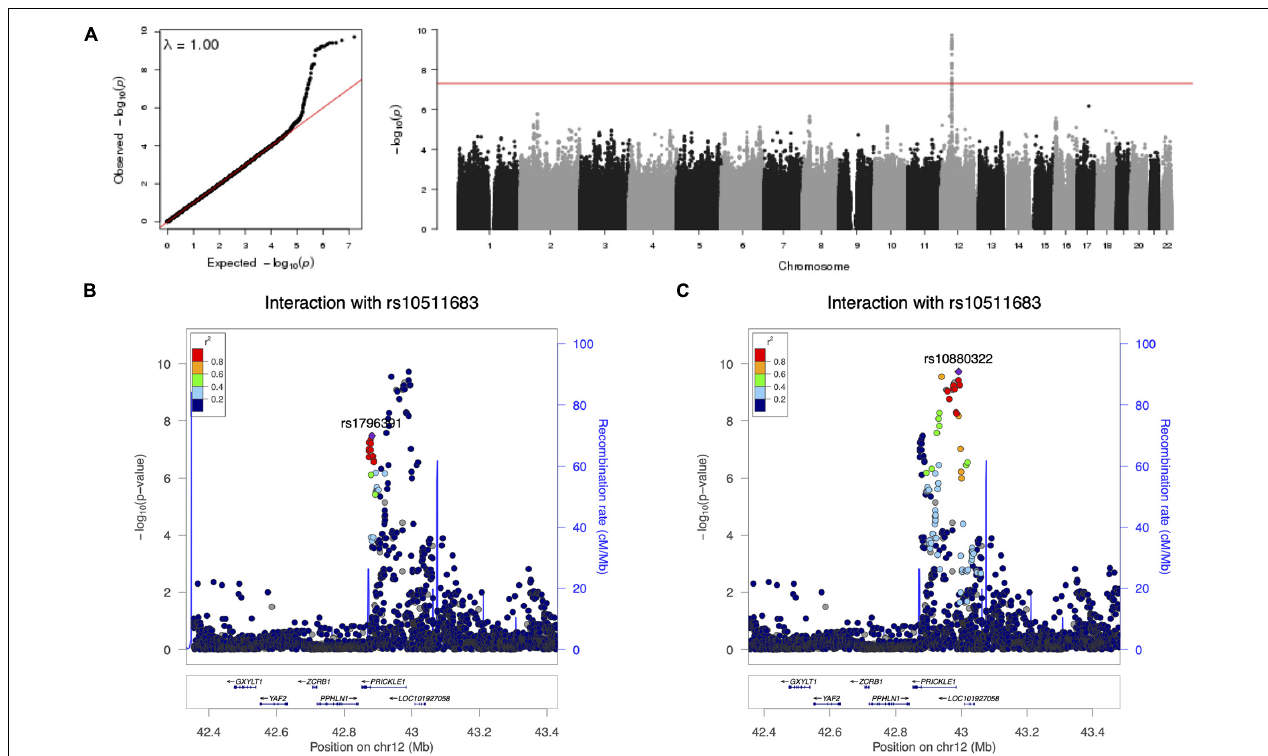
FIGURE 5 | Results of a genome-wide gene-by-gene (G × G) interaction search for loci interacting with FOCAD rs10511683. (A) Q–Q plot and Manhattan plot. The red horizontal line indicates 5 × 10 - 8 . (B) Regional association at the PRICKLE1 locus, colored by the linkage disequilibrium (LD) with the suggestive variance quantitative trait locus (vQTL) rs1796391. (C) The same region as in (B) , colored by the LD with the other lead SNP